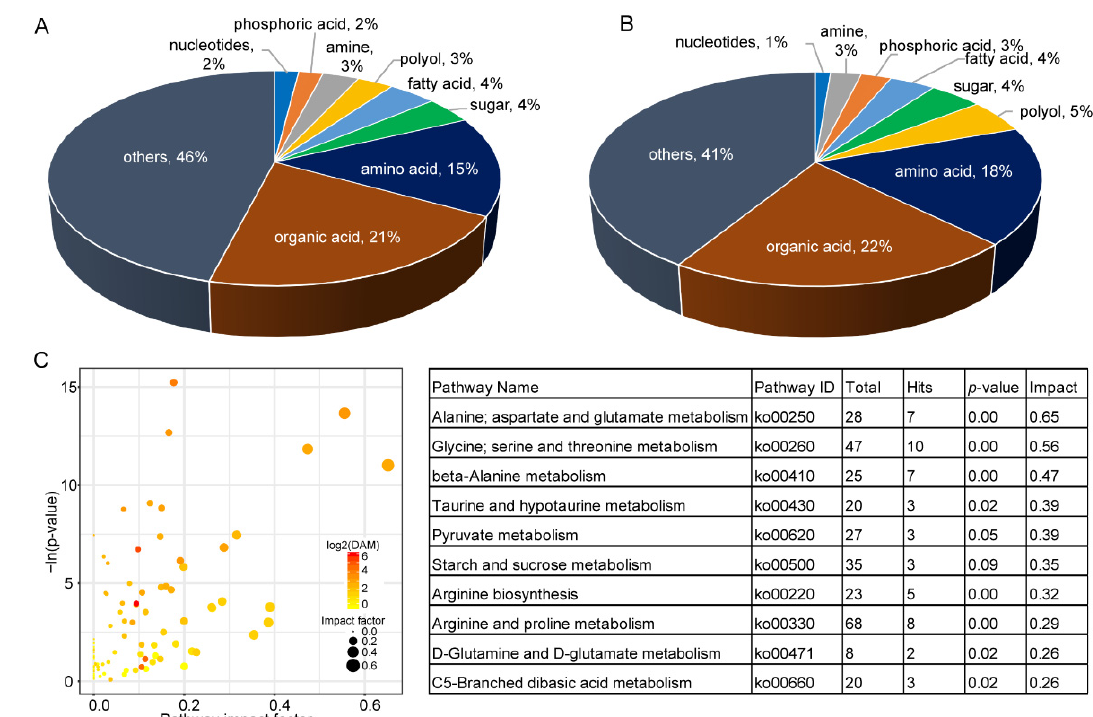
Figure 2. Metabolites identified by GC-MS and LC-MS. ( A ) Total metabolites. ( B ) Differentially accumulated metabolites (DAMs). ( C ) KEGG pathway enrichment analysis of DAMs. Left, overview of the enrichment analysis; right, top 10 enriched pathways (with the highest value of impact factor). Total, number of genes annotated in a pathway; Hit, number of genes hits in a pathway.